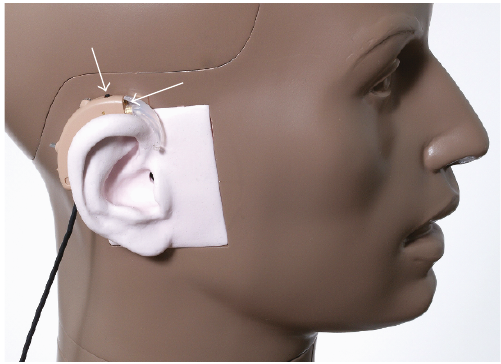
Figure 2: Behind-the-ear housing containing the two-omni- directional microphones (arrows) mounted on KEMAR